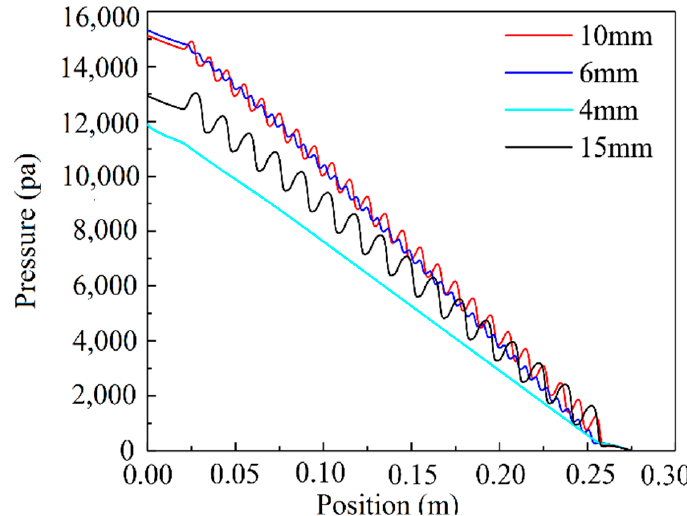
Figure 12. Curves of pressure variation along the system under different